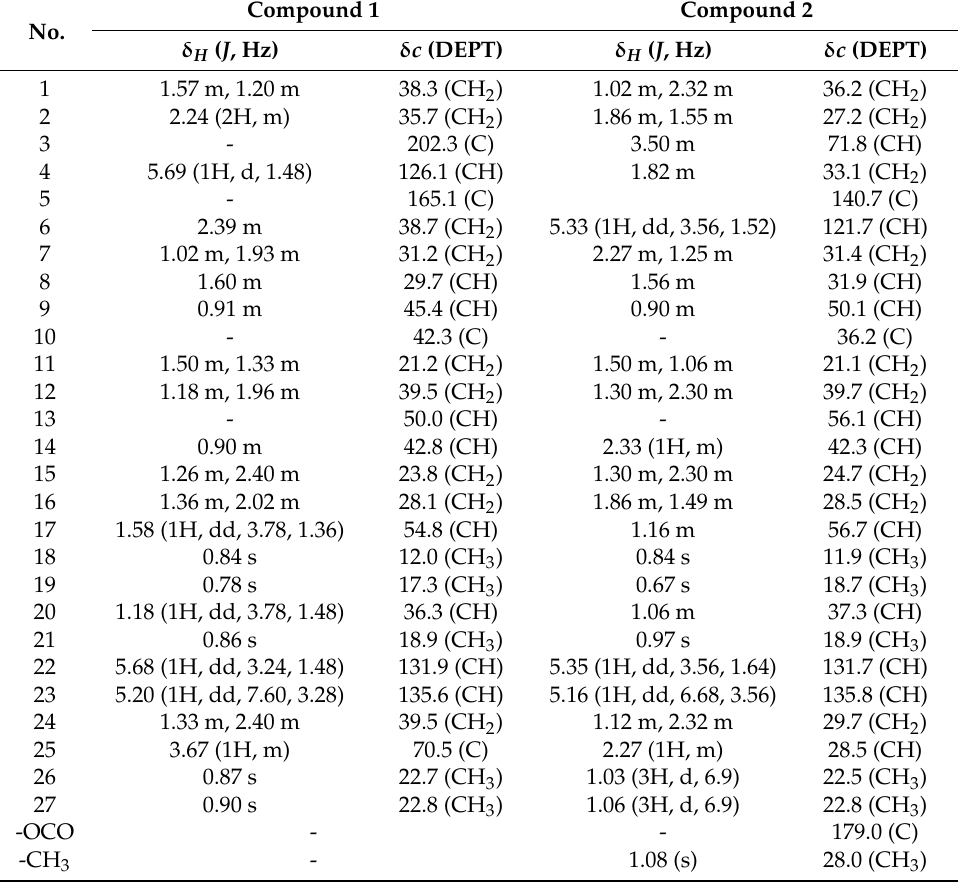
Table 1. 1 H-NMR (400 MHz) and 13 C-NMR (100 MHz) data of compounds 1 and 2 (in CDCl 3 ).